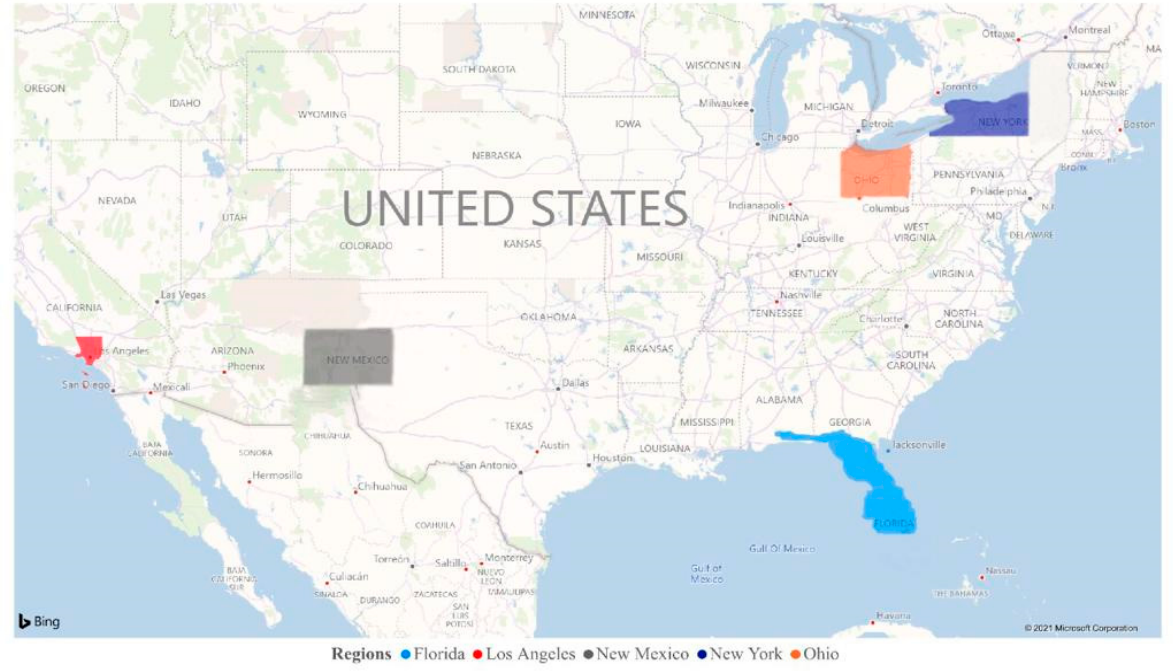
Figure 1. Map of the USA, highlighting five selected regions. Florida: light blue; Los Angeles: red; New Mexico: gray; New York: dark blue; and Ohio: orange.